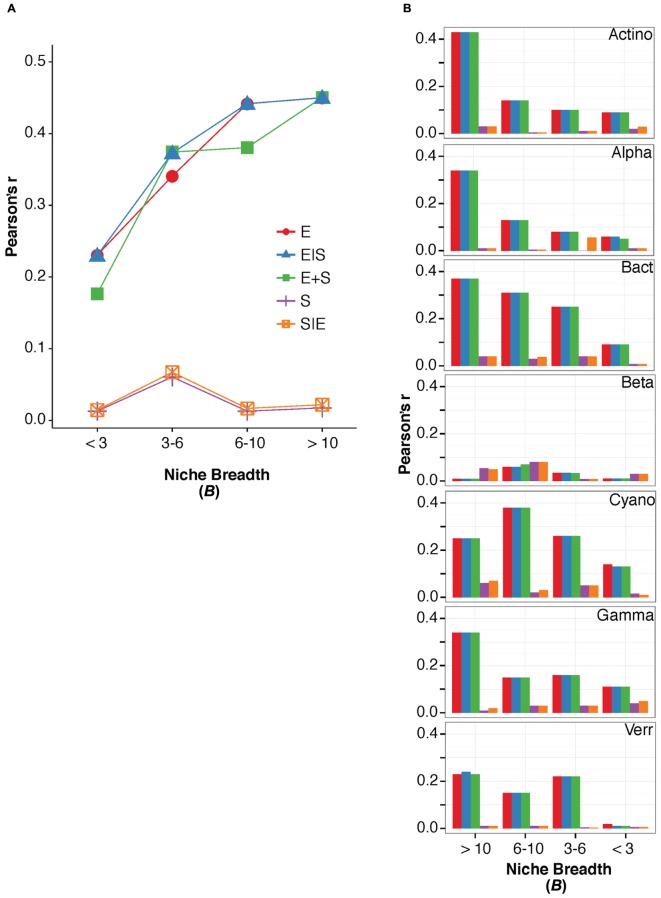
The variation in bacterioplankton community composition that can be explained by the environmental and spatial factors within niche breadth calculated for all bacteria divided into groups of B > 10, B = 6–10, B = 3–6, and B < 3 (A), and within niche breadth calculated for specific bacterial groups (B). Names of major bacterial groups are abbreviated; Actinobacteria (Actino), Alphaproteobacteria (Alpha), Bacteroidetes (Bact), Betaproteobacteria (Beta), Cyanobacteria (Cyano), Gammaproteobacteria (Gamma), Verrucomicrobia (Verr).